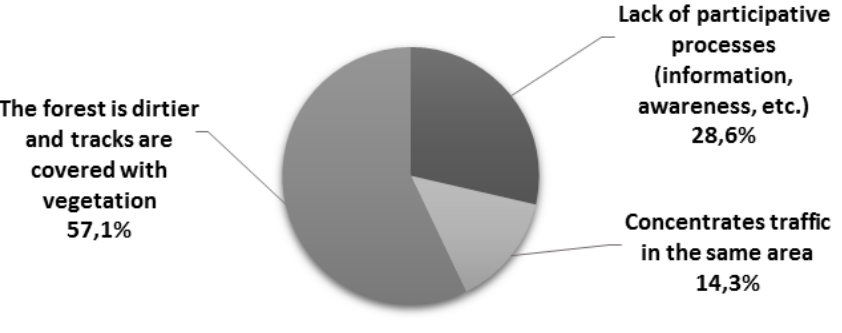
Figure 3. Interviewees who affirm the regulations do not contribute to the island’s forest